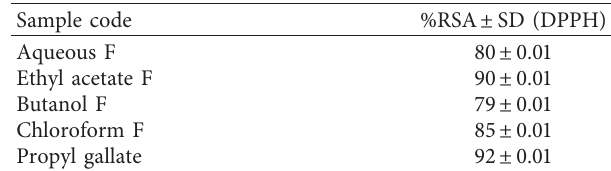
Table 3: Antioxidant activity of different methanolic fractions.